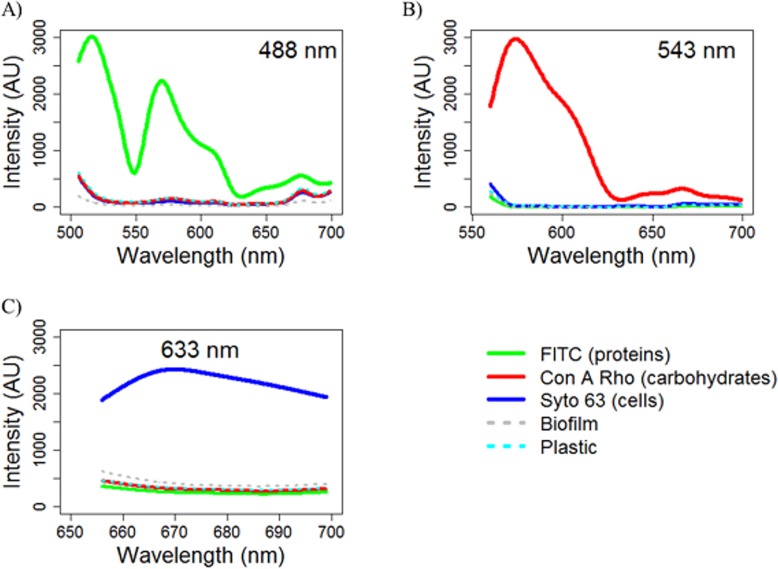
Emission spectra (fingerprints) of the triple stain combination targeting cells (Syto 63), carbohydrates (Con A Rho) and proteins (FITC), at each excitation wavelength.Note that plastic/biofilm autofluorescence is also shown and that the whole spectrum in each case was used in linear unmixing. A) Emission at 488 nm excitation, image settings for FITC; B) Emission at 543 nm excitation, image settings for Con A Rho; C) Emission at 633 nm excitation, image settings for SYTO 63.